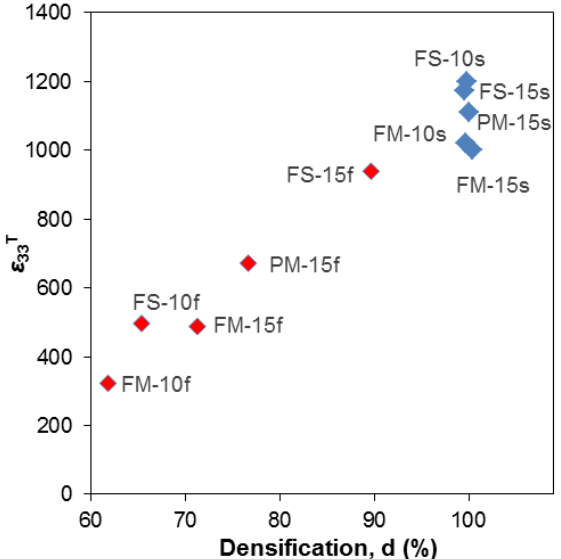
Figure 4. Correlation between percent density of the samples and relative dielectric constant measured at 1 kHz. Fast-sintered samples are shown as red diamonds, slow-sintered samples are shown as blue diamonds. Most low-density samples were obtained at fast sintering. Slow sintered samples mostly display the highest relative dielectric constant values.